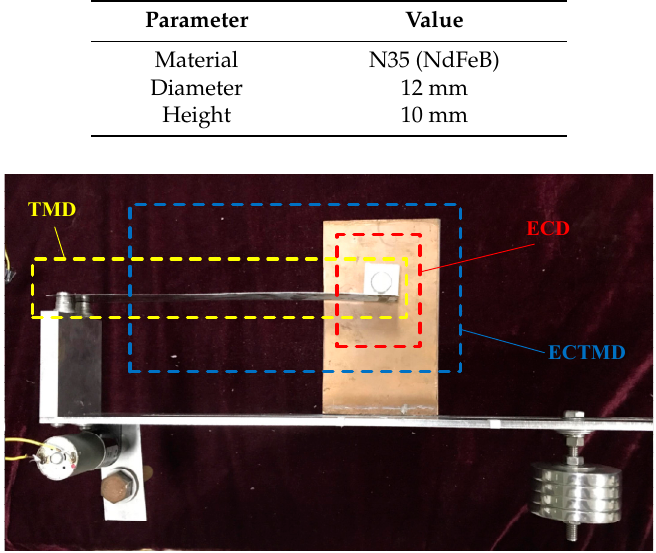
Figure 4. The configuration of the ECTMD.